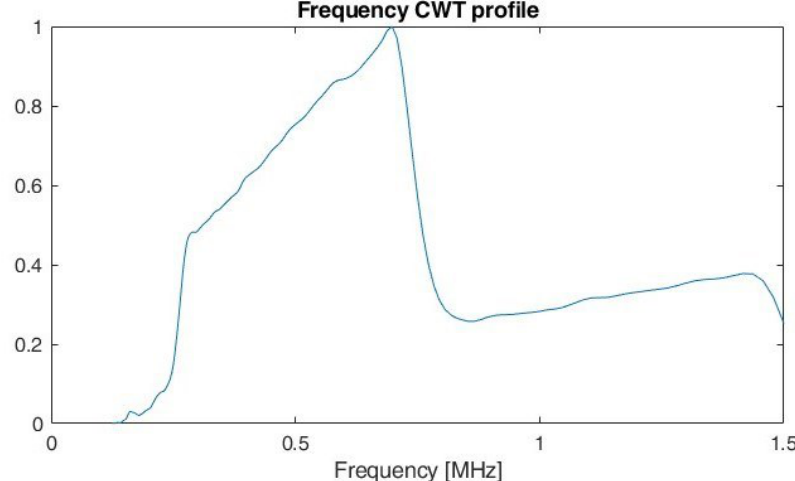
Figure 11. Frequency CWT profile for LFMCW.